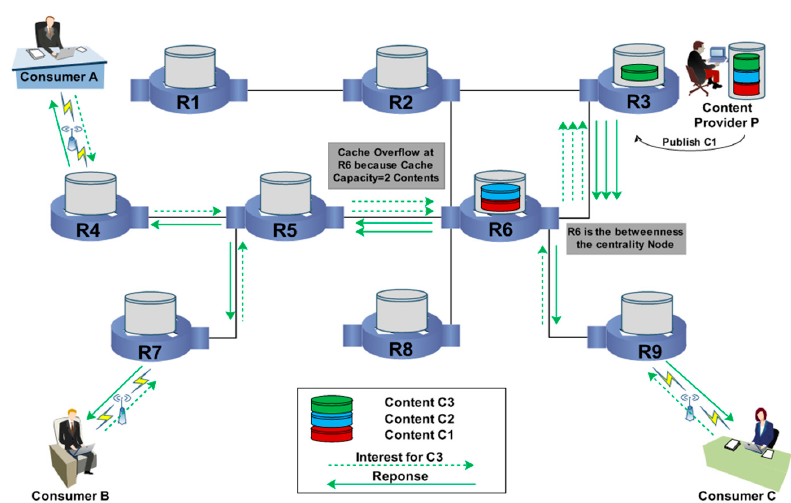
Figure 4. Centrality-Based Caching Strategy.